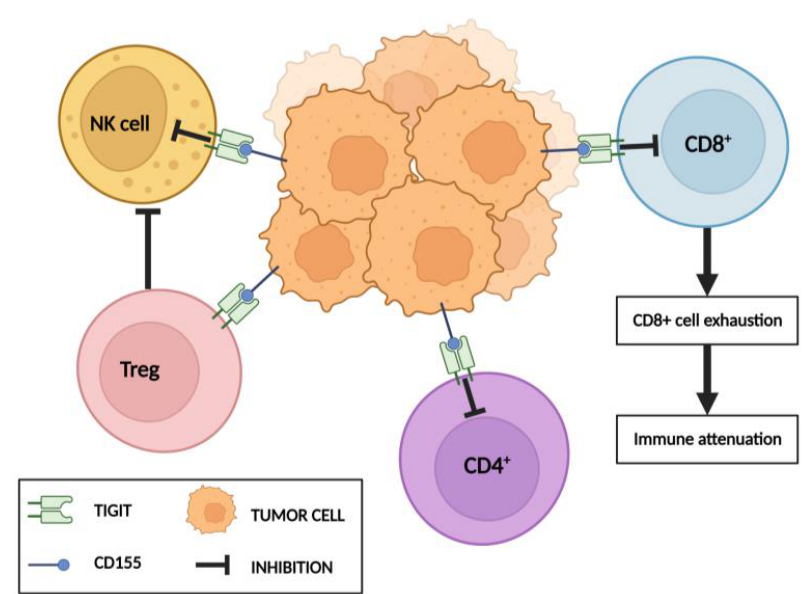
Figure 1. Mechanisms of TIGIT interaction with T lymphocytes and NK cells. TIGIT via its receptor CD155 triggers direct inhibitory signals in T lymphocytes and NK cells. Cytotoxic T lymphocytes undergo exhaustion. In turn, TIGIT signaling enhances immunosuppressive functions of Treg cells. Both actions consequently lead to immune system attenuation. Created with Biorender.com (accessed on 20 December 2022).